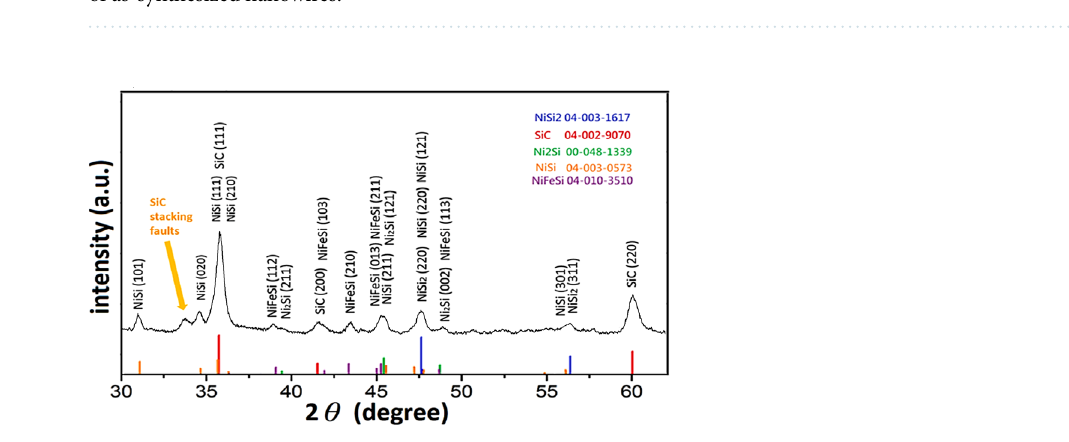
Figure 1. ( a ) Low magnification SEM images of as-synthesized nanowires, ( b ) high magnification SEM images of as-synthesized nanowires.